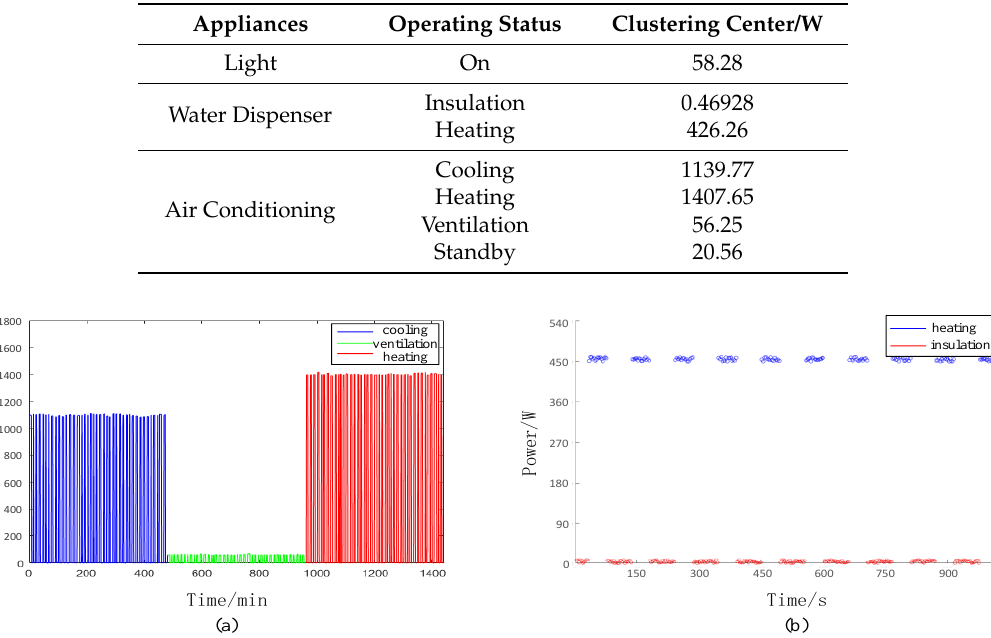
Figure 1. The operating status recognition results. ( a ) The operation status recognition of the air conditioning unit. ( b ) The operation status recognition of the water dispenser.